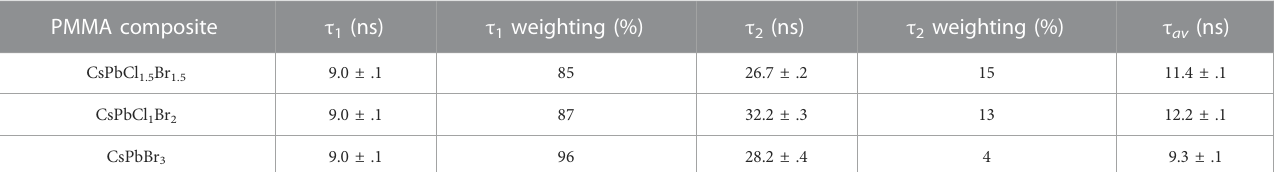
TABLE 2 Decay times and their relative weightings for the time decay curves of the CsPbX 3 composites in PMMA, illuminated by a pulsed 405 nm laser and fi t with biexponential curves. PMMA composite